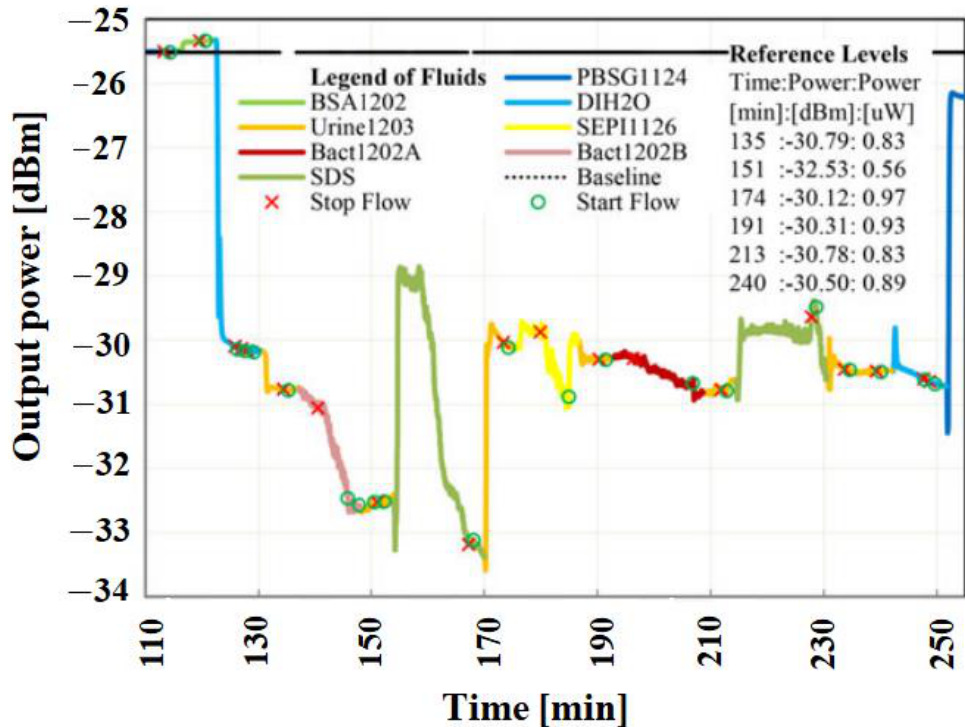
Figure 9. Selective detection of Gram-negative bacteria ( E. coli ) in urine using a LRSPP straight waveguide biosensor functionalized using Protein G and antibody against Gram-negative bacteria [128,129]. Bact1202A was a positive control urine solution with a high E. coli concentration of 10 10 CFU/mL. Bact1202B was a positive control urine solution with a low E. coli concentration of 10 6 CFU/mL. SEPI1126 was a negative control urine solution with a Gram-positive bacteria (s.epi) concentration of 10 12 CFU/mL. The refractive index at 1310 nm of Urine1203 is 1.32276 and of PBSG1124 (buffer) is 1.33152. Copyright requires permission from IEEE Ref. [130].